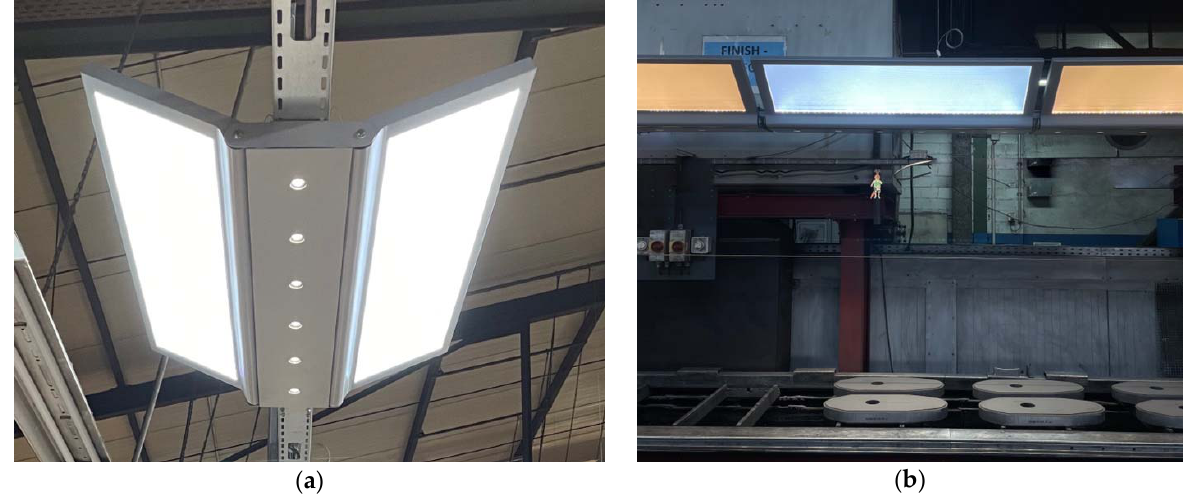
Figure 3. Photographs of the Drosa luminaire. ( a ) The linear central component (called direct component) is attached to a standard cable tray and contains six glare-free downlights with a CCT of 4000 K. One or, as shown here, two wings attach to the direct component. Their angle can be freely adjusted between a horizontal and vertical orientation. ( b ) The wings can be adjusted in CCT between 1800 and 8000 K (here shown for comparison in one picture, which is not a used setting). In the case of the quality control workplaces, where the luminaire is mounted at a height of about 2.0 m, the direct component is almost invisible but responsible for most of the light on the task level.